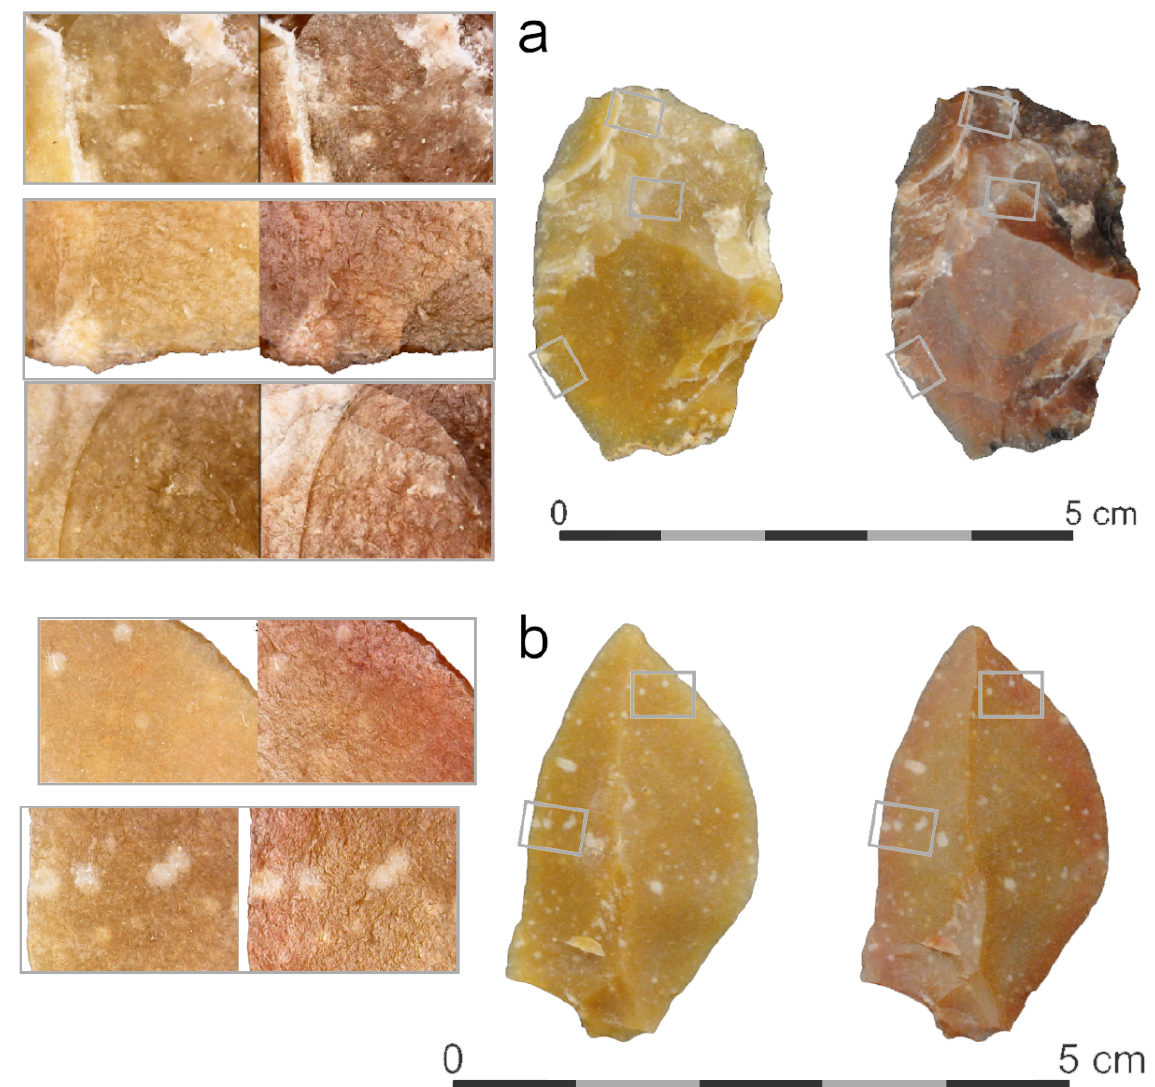
Figure 10. Macro and detail photos of Bergerac blanks located a) 2.5 cm and b) 5 cm below the hearth; a) presents SAL2 showing the development of the characteristic waxy luster and presence of scales (second and bottom detail photos); b) blank that presents SAL1 with characteristic waxy luster, lower level of dehydration and original color associated to developed